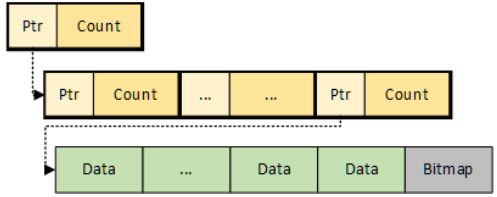
Figure 4. Schematic diagram of a level